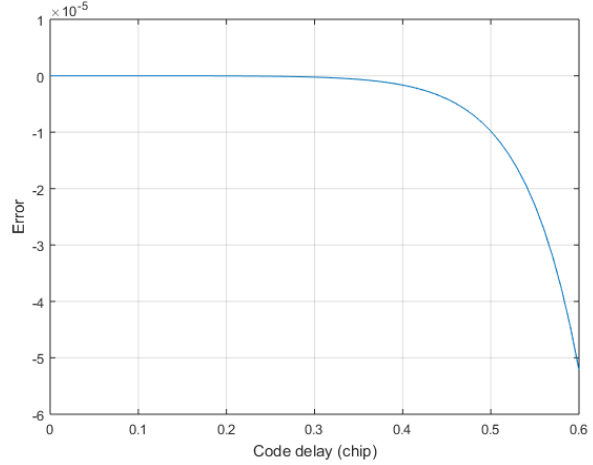
Figure 10. The 24-order Taylor approximation error when β = 1.6.